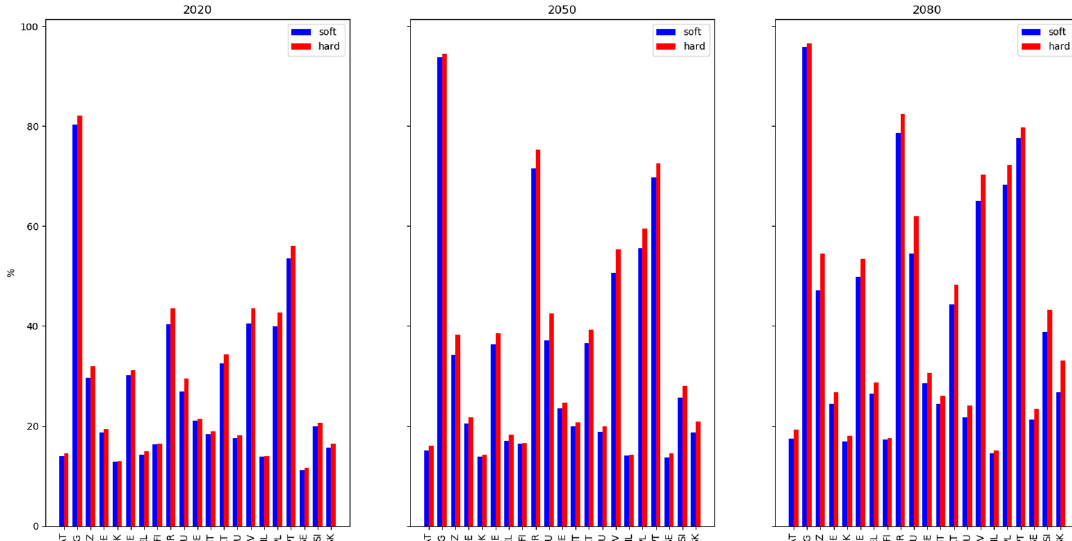
Figure A1. The percentage of the population that cannot afford insurance under soft market conditions (blue) and hard conditions (red), for EU countries in 2020, 2050, and 2080, for RCP8.5. Countries that provide public reinsurance for flood insurance are excluded here, as these are not exposed to global reinsurance market volatility resulting from large natural catastrophes.